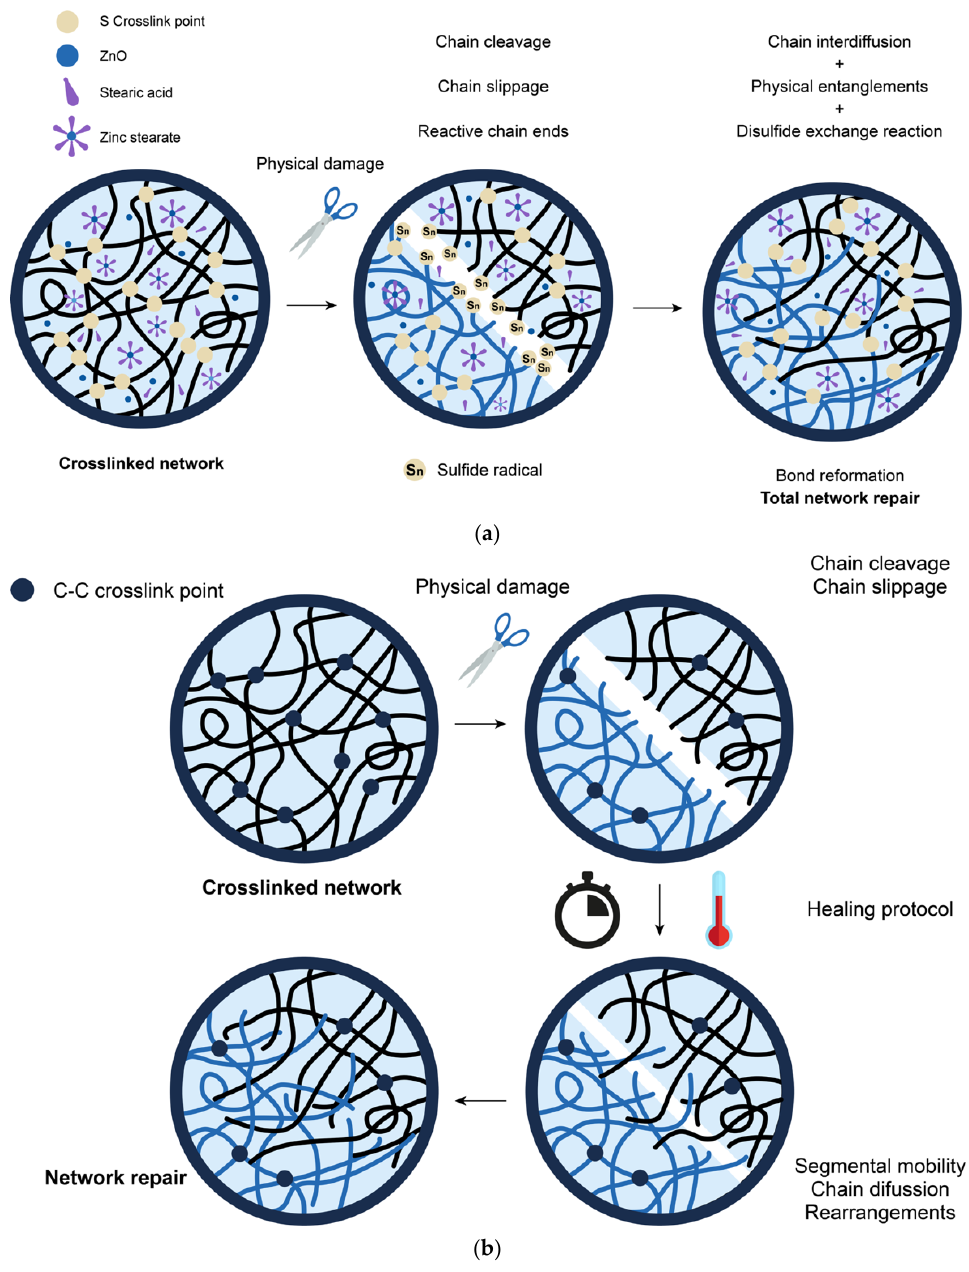
Figure 9. Schematic representation of self-healing process in ( a ) sulfur-based and ( b ) peroxide-based SBR. Adapted with permission from [50]. 2022, Elsevier.